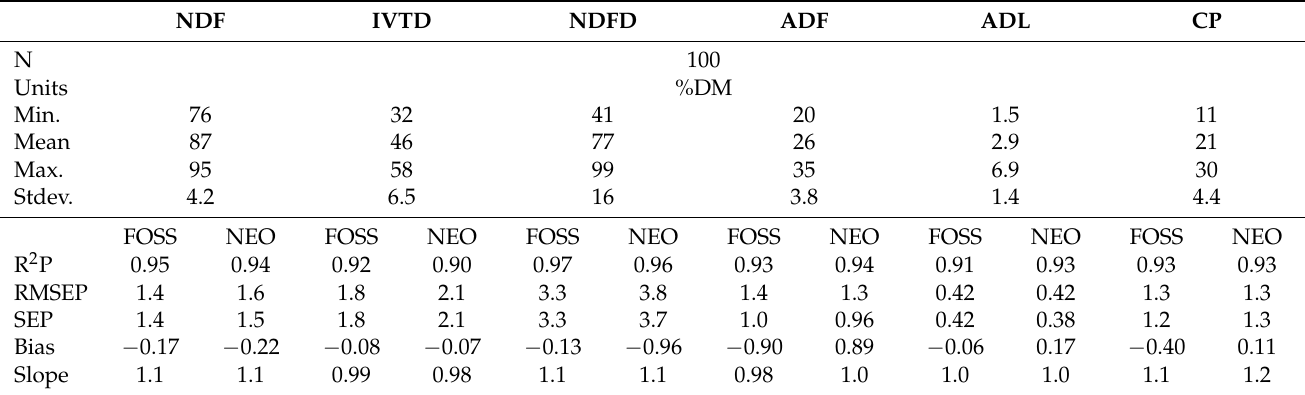
Table 2. Statistics of validation results for predicting forage nutritive value from a model that combines data from fresh alfalfa (N = 20) and fresh grass (N = 80) samples using the NIRSystems 6500 (FOSS), and the NeoSpectra-Scanner handheld instrument